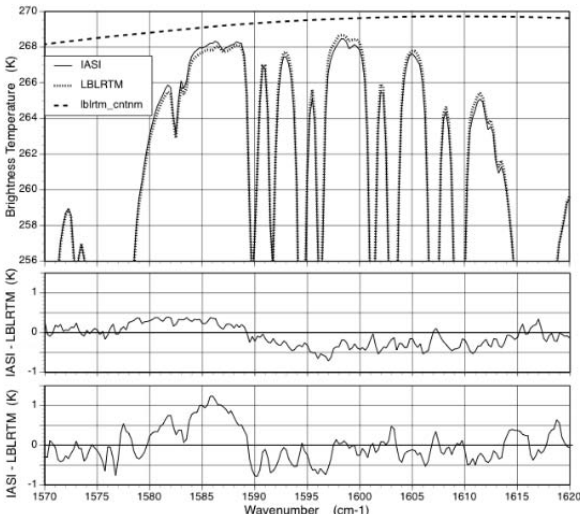
Fig. 20. Brightness temperatures and residual spectra for the water vapor band center, showing the residual feature associated with the water vapor continuum. Top: Measured and modeled brightness temperatures for the land case. Middle: Residuals for the land case. Bottom: Residuals for the ocean case.